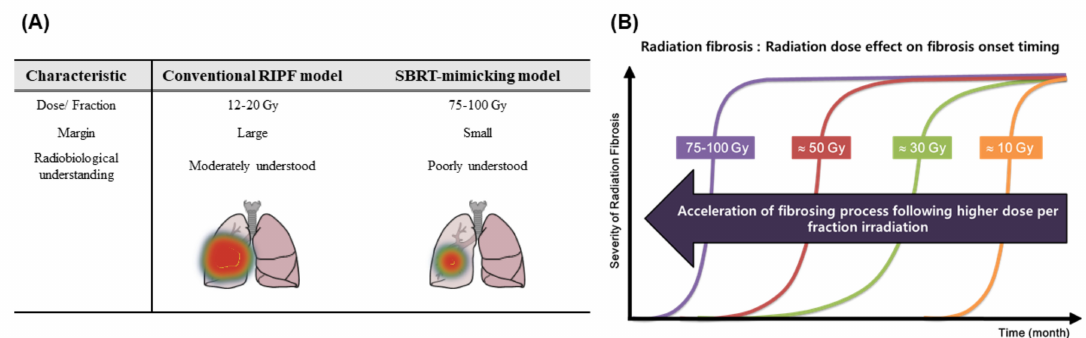
Figure 3. General comparison of conventional and stereotactic SBRT-mimicking RIPF